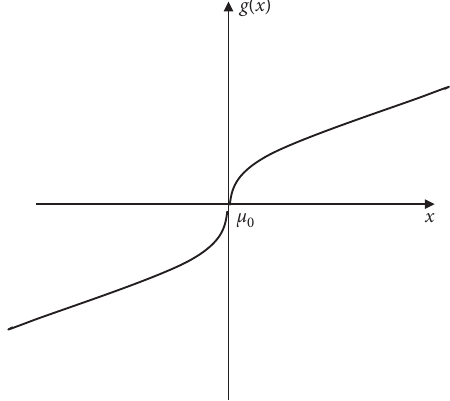
Figure 4: The value function in the prospect theory.